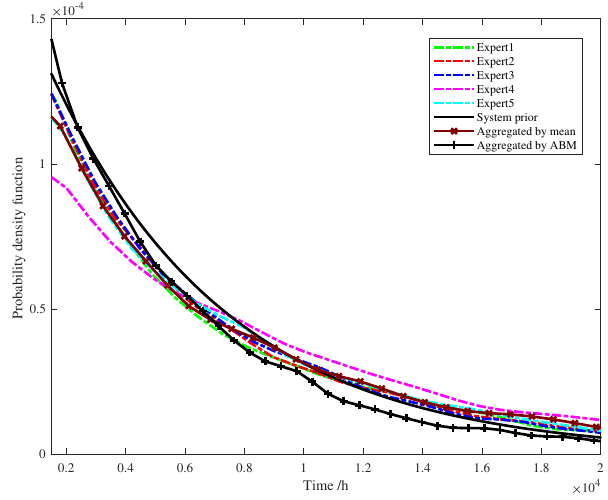
Figure 6. Comparisons of each expert’s judgment, aggregated by the mean and adaptive Bayes melding (ABM)